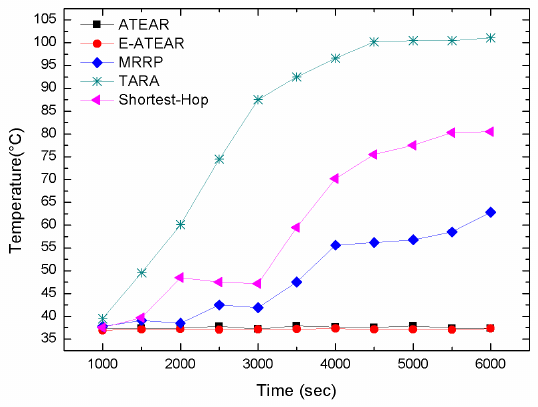
Figure 5. Average temperature rise versus simulation.